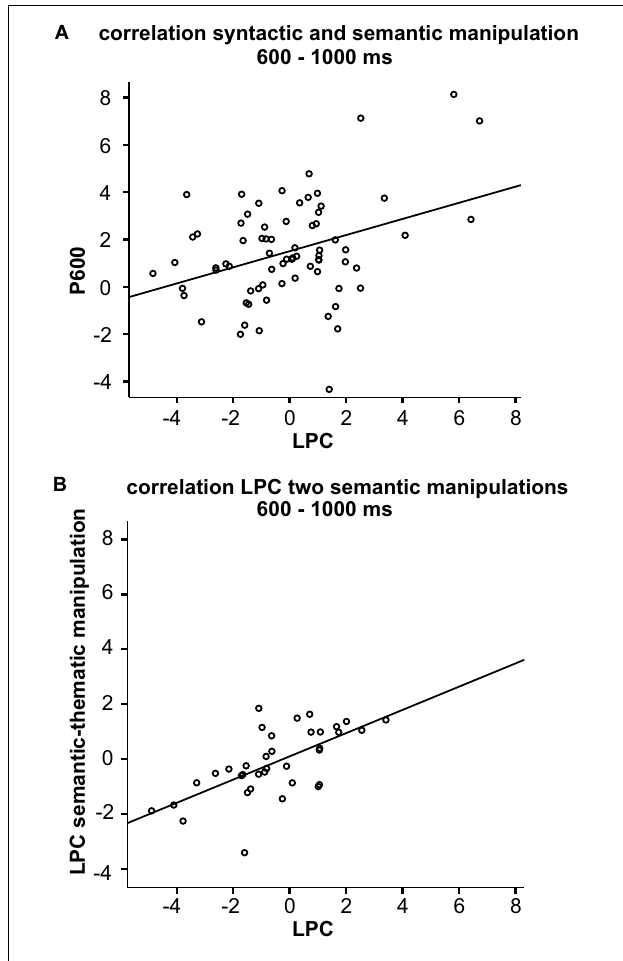
FIGURE 3 | Effect sizes per participant for the semantic manipulation within (A) the LPC time window (600–1000ms) and (B) the N400 time window (300–600ms). (C) Effects per participant on the word two positions before the critical word of the semantic manipulation between 600 and 1000ms. Participants are sorted on LPC effect size for easier comparison between the figures.